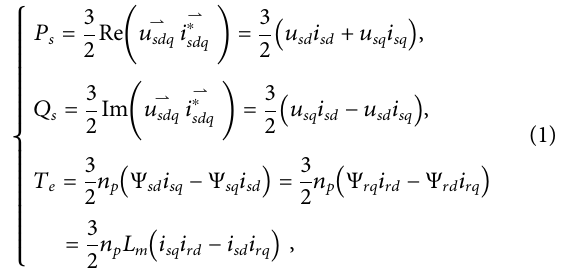
Frontiers in Energy Research |